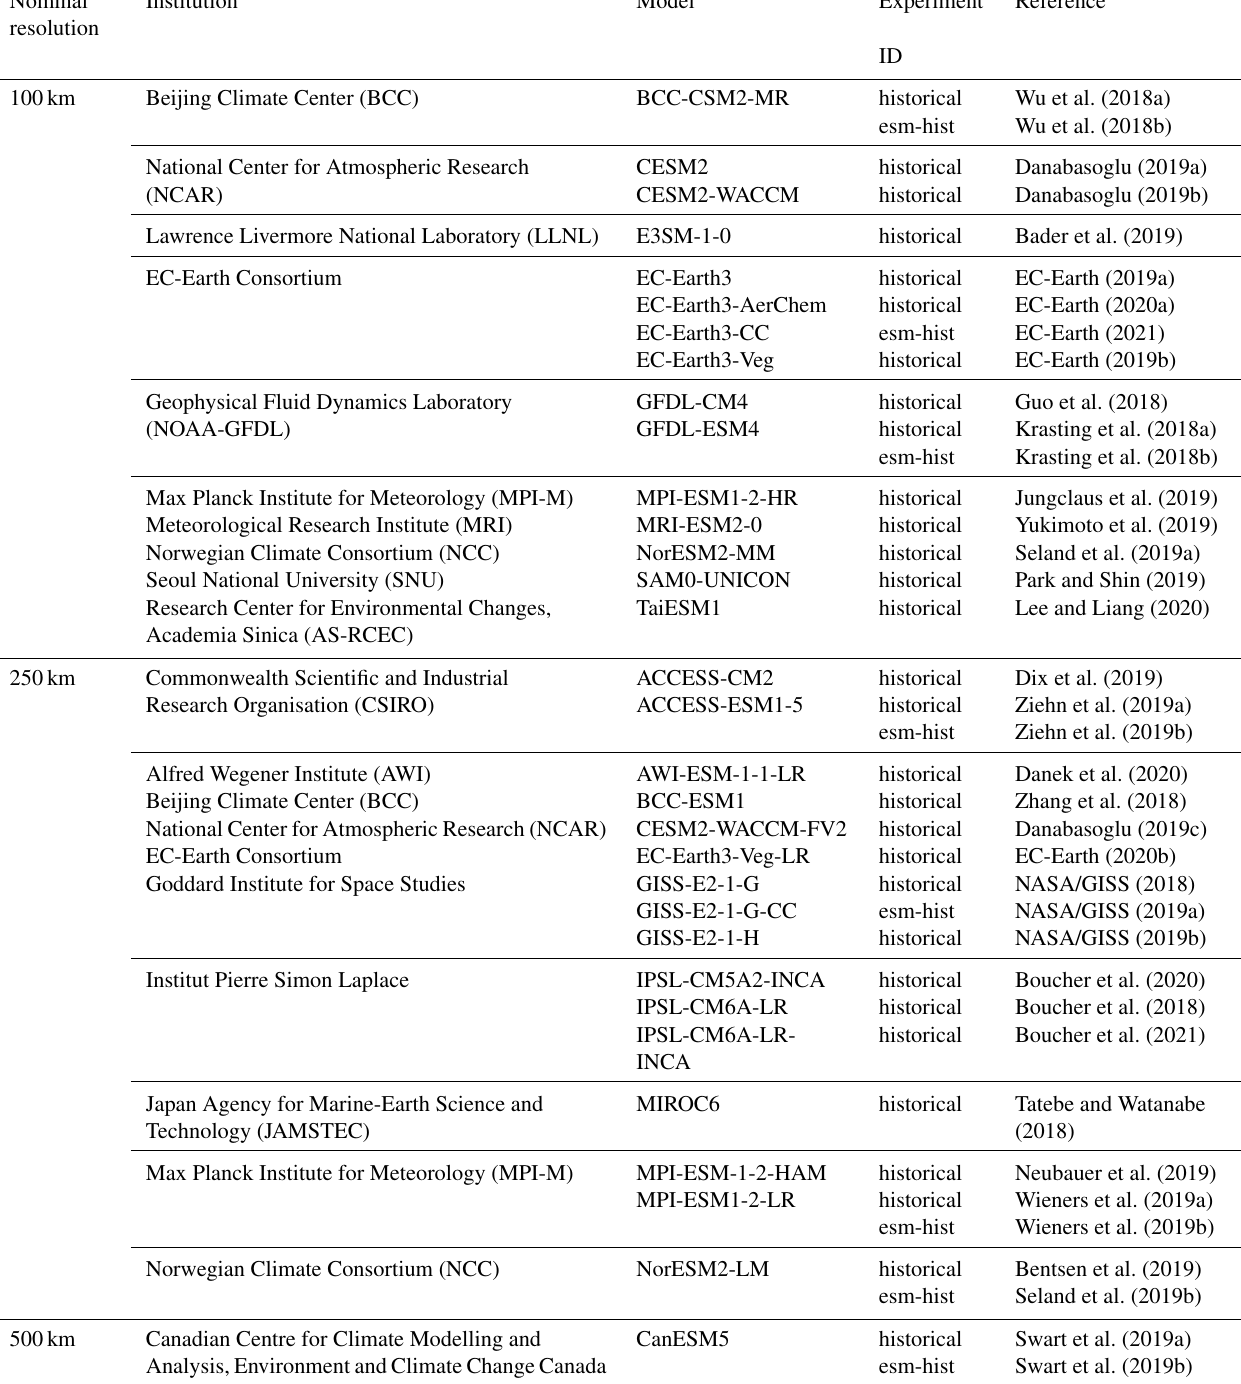
Table 1. CMIP6 models used in this